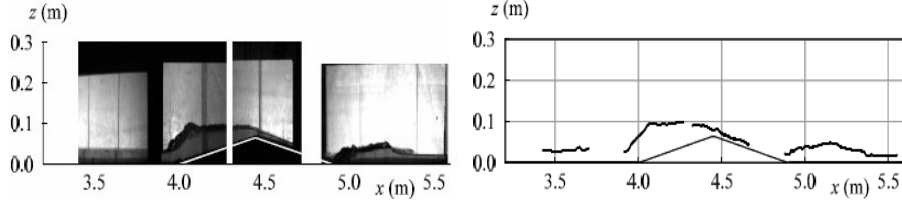
Fig. 10. Water surface at 1.8s (Soarez et al., 2002): the position of the free surface is measured by an automatic recognition procedure to each filmed image.